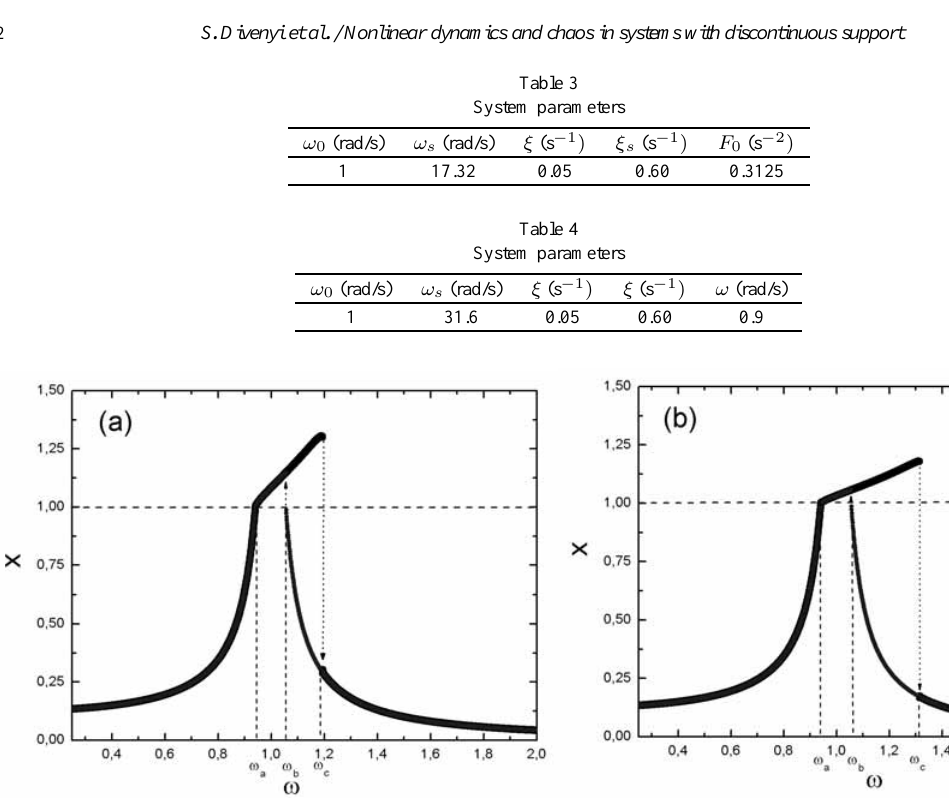
Fig. 6. Frequency domain analysis.